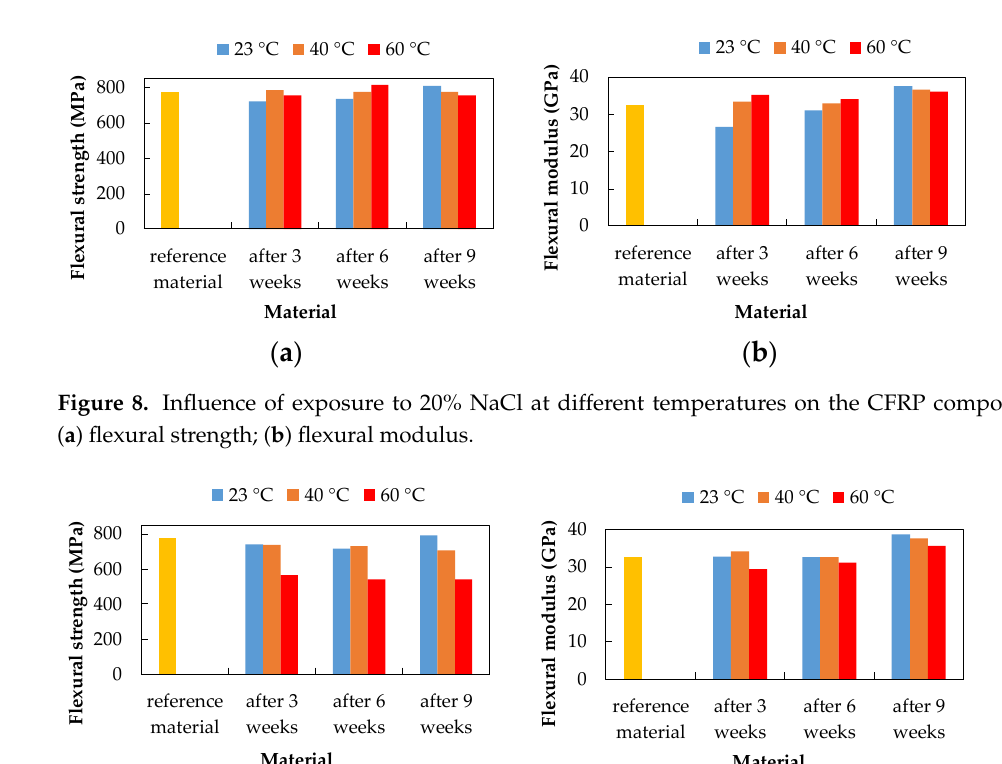
Figure 9. Influence of exposure to 10% NaOH at different temperatures on the CFRP composite; ( a ) flexural strength; ( b ) flexural modulus.